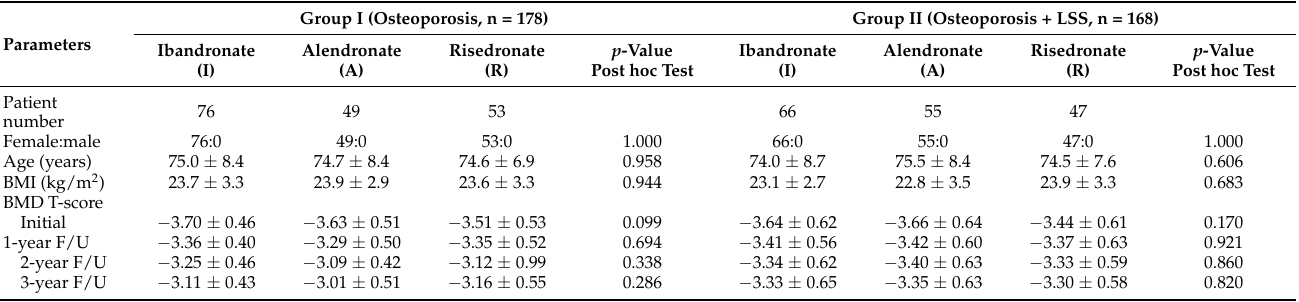
Table 3. Annual BMD T-scores and changes in BMD according to the three different types of BP in each